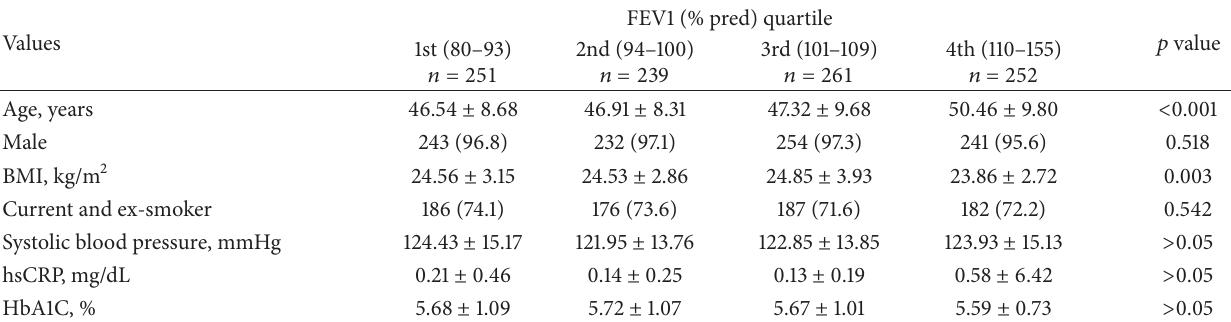
Table 2: Baseline characteristics by FEV1 (% pred) quartiles.